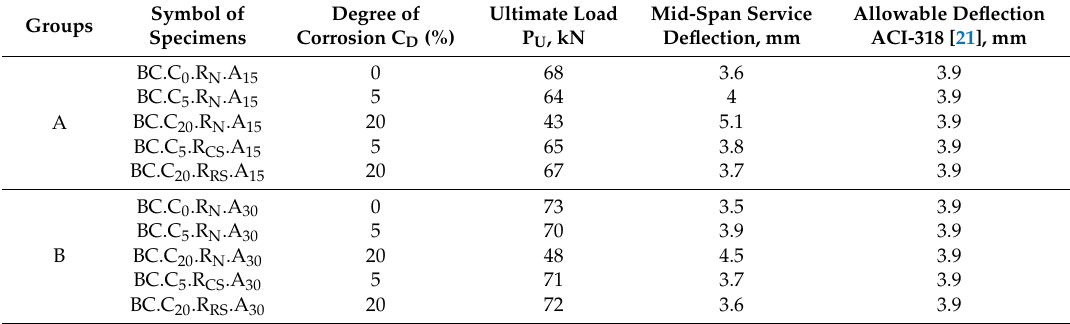
Table 3. Ultimate load capacity and service deflection for tested